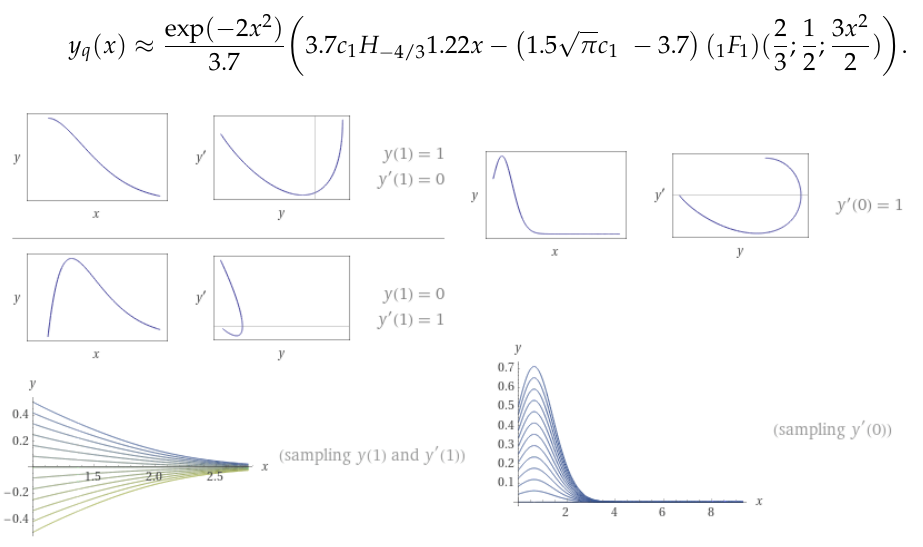
Figure 1. The solution of (13) for ℘ = 1.